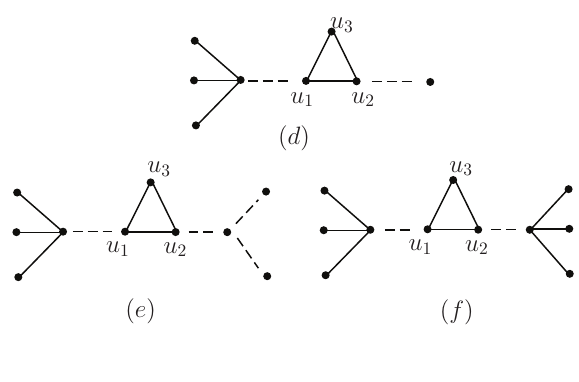
Figure 7: The graph class